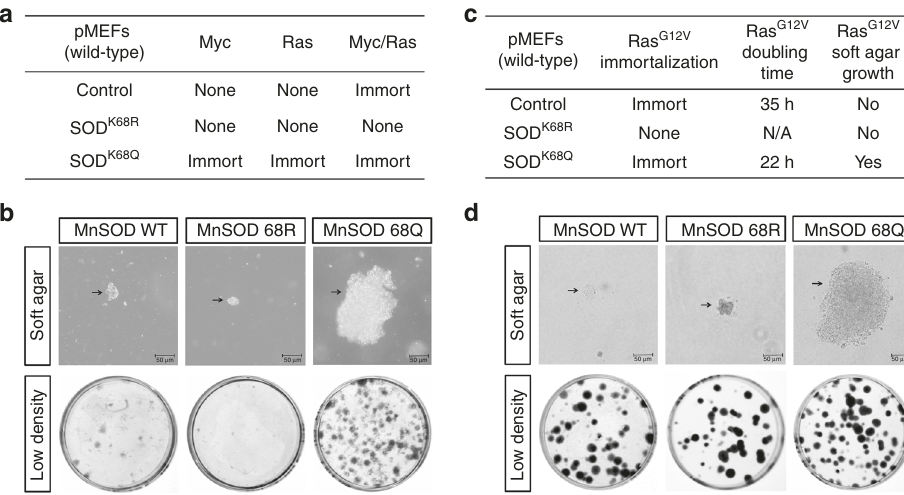
Fig. 1 MnSOD K68Q expression promotes a transformation-permissive phenotype in vitro. a Immortalization, i.e., growth beyond 15 passages, of pMEFs infected with lenti-MnSOD WT , lenti-MnSOD K68R , and lenti-MnSOD K68Q and either lenti-Myc or lenti-Ras. b The cell lines above were tested for soft agar growth (upper) and colony formation (lower panels). c pMEFs infected with Ras G12V were tested for immortalization, doubling time, and soft agar growth. d NIH 3T3 cells expressing MnSOD WT , MnSOD K68R , and MnSOD K68Q were tested for growth in soft agar (upper) and colony formation (lower panels). Experiments done in triplicate. Scale bar: 20 μ